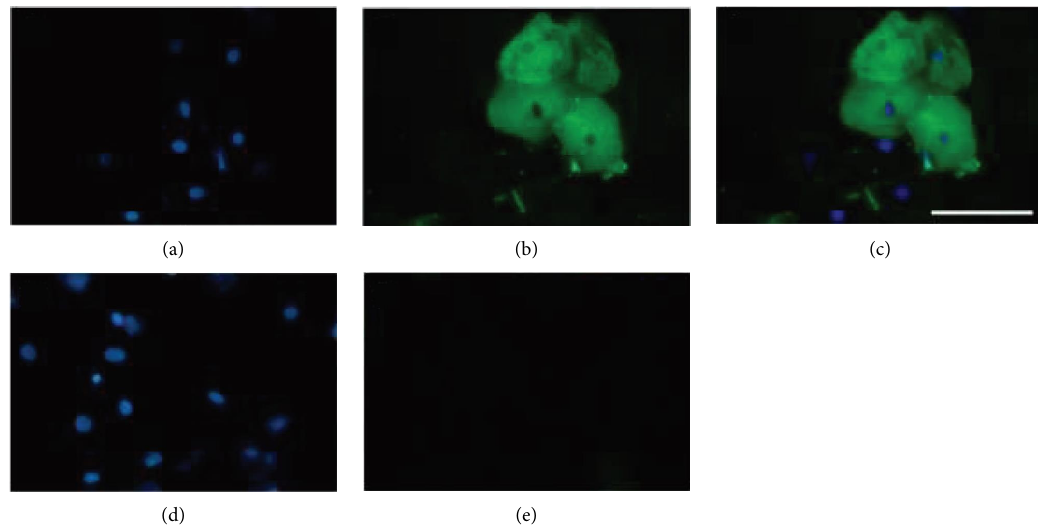
Figure 2: Immunocytochemistry reveals EGF immunoreactivity in DOECs. (a–e) Cells were transferred to microscope slides using the cytospin technique and fxed. Te same cells were double stained for nuclei using the nuclear marker DAPI (a, d) and for EGF im- munoreactivity (b, e). Overlay of DAPI stain and EGF immunoreactivity is shown in panel (c). For negative controls, the primary EGF antibody was omitted (d, e). Te bar in panel (c) represents 100 μ m for all panels. Each sample was analyzed in duplicate or triplicate. EGF immunoreactivity was assessed in cells isolated from one of the four volunteers included in the study. Pictures were obtained using an Olympus BX60 fuorescence microscope equipped with a digital camera and appropriate flter settings.